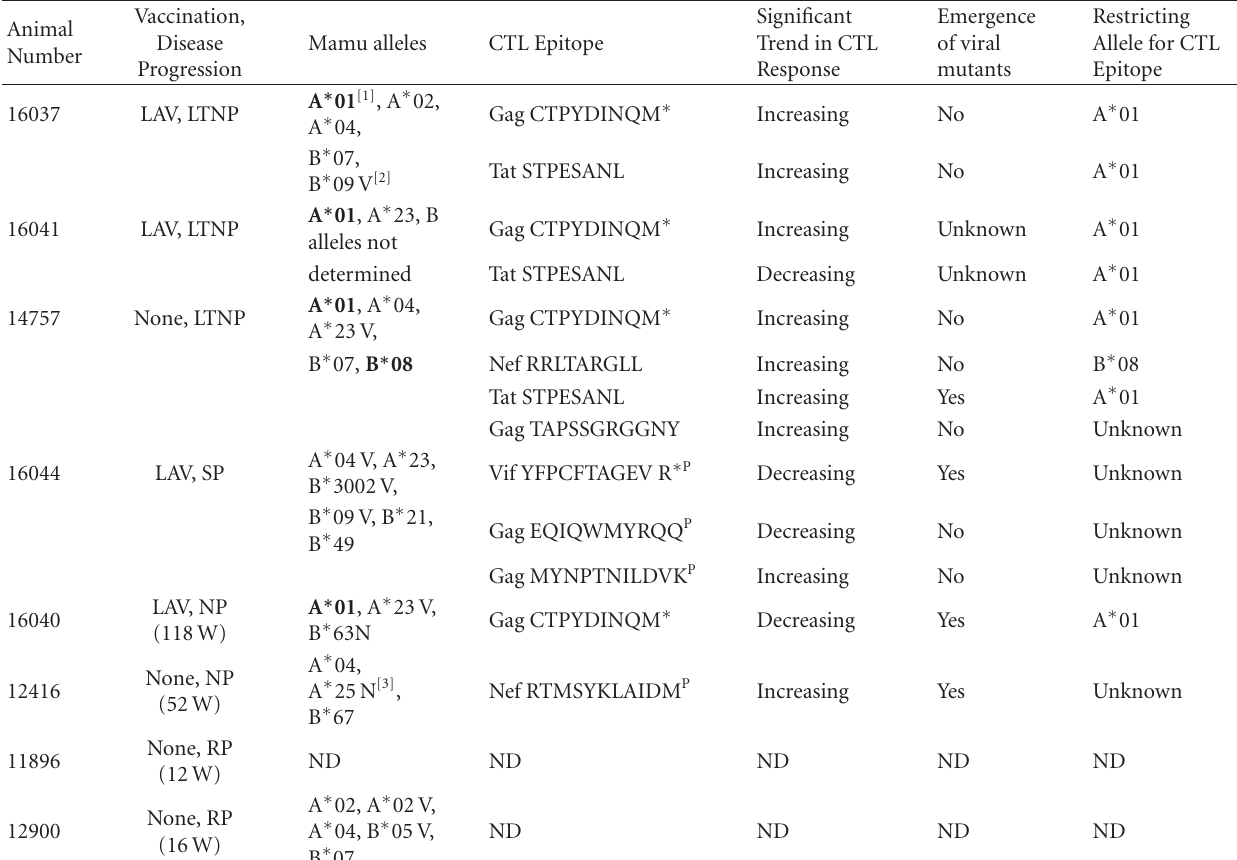
Table 1: MHC class I allele and CTL Epitope